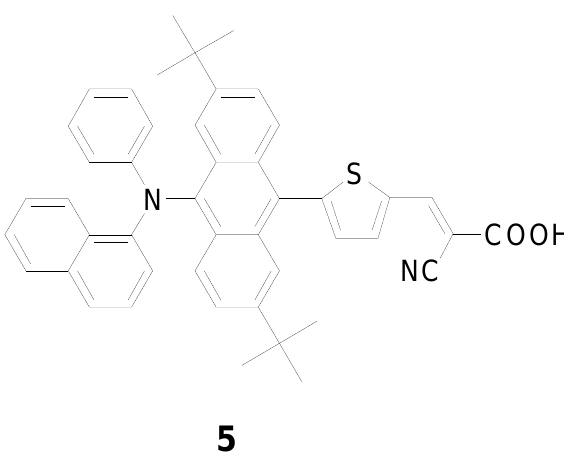
Figure 2. Structure of the compound 5 .